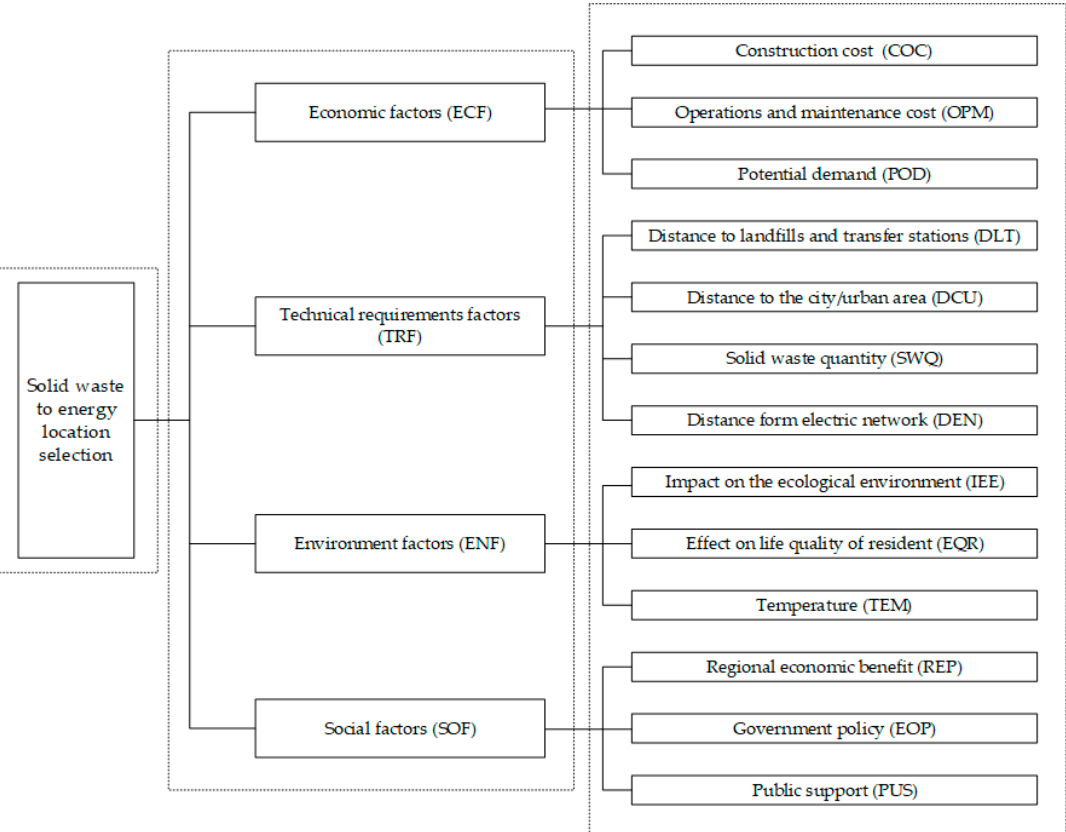
Figure 6. The geographical location of DMU. (Source: UN Development Programme.)